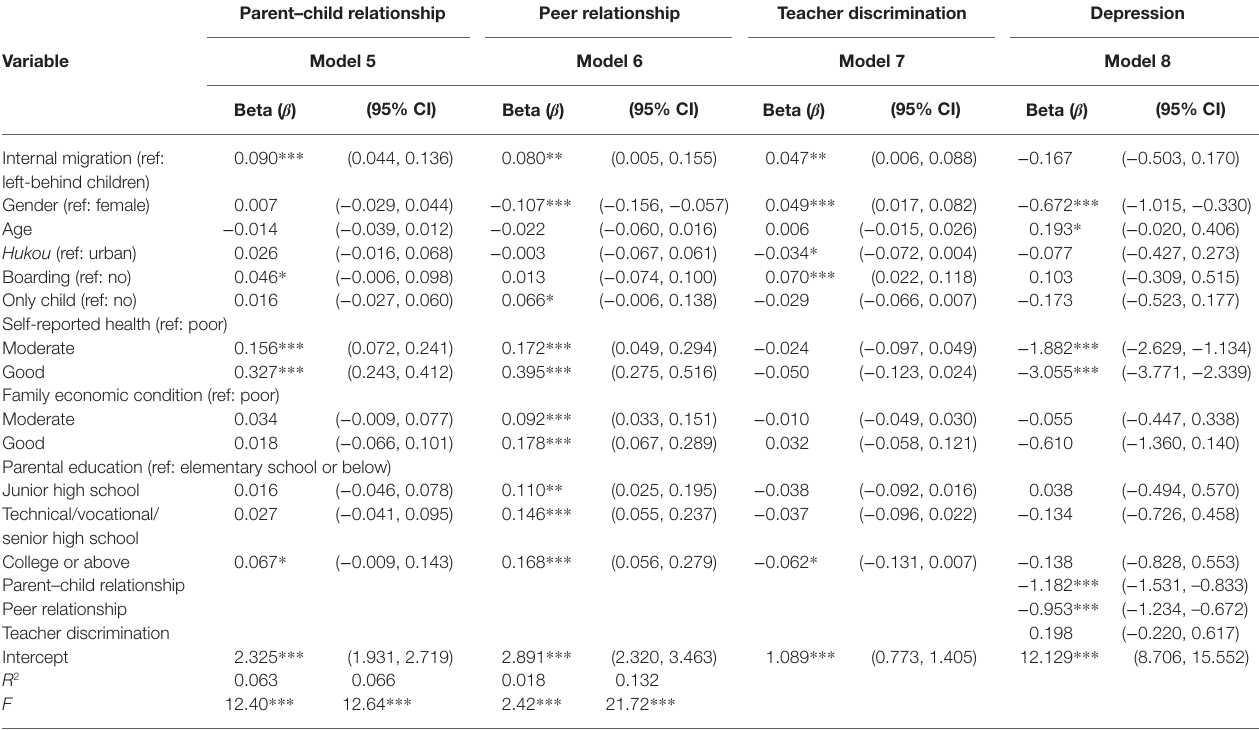
TABLE 5 | Results of mediation analysis for depression. Parent–child relationship Peer relationship Teacher discrimination